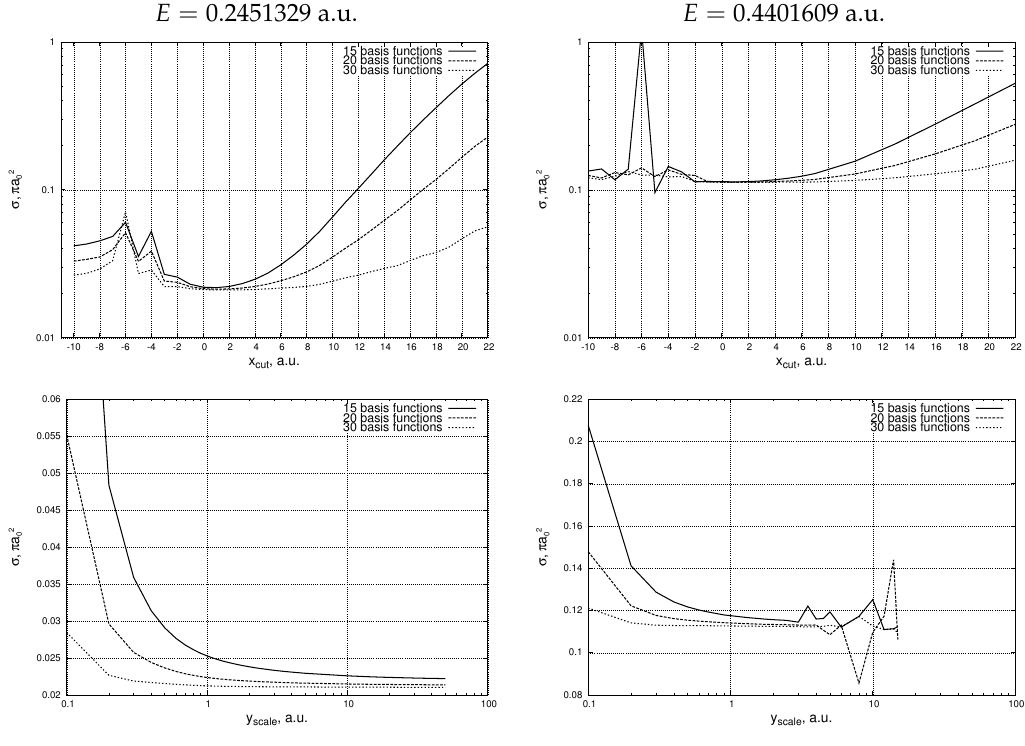
Figure 6. Stability of the calculated elastic cross section with respect to the parameters of the splitting